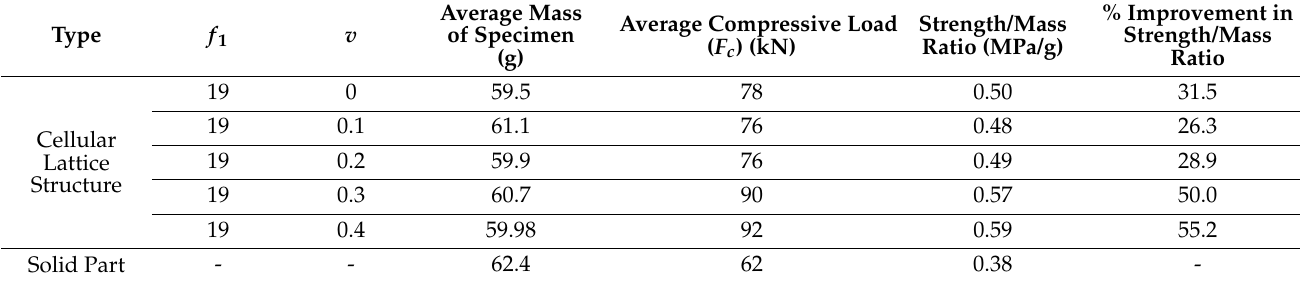
Table 8. Second test series results of test specimens with frequency 19 and 70% infill